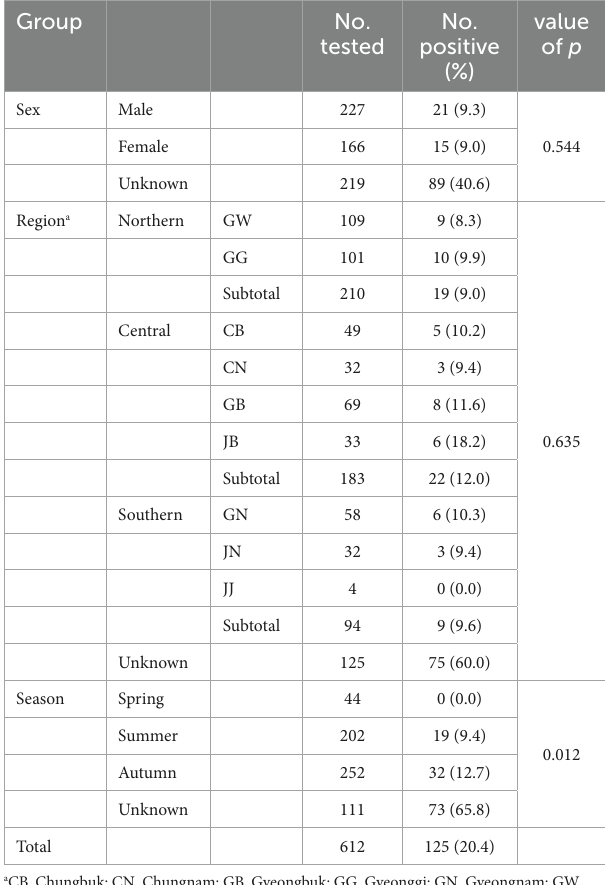
TABLE 1 Giardia duodenalis infection in wild boars based on 18S rRNA amplification.